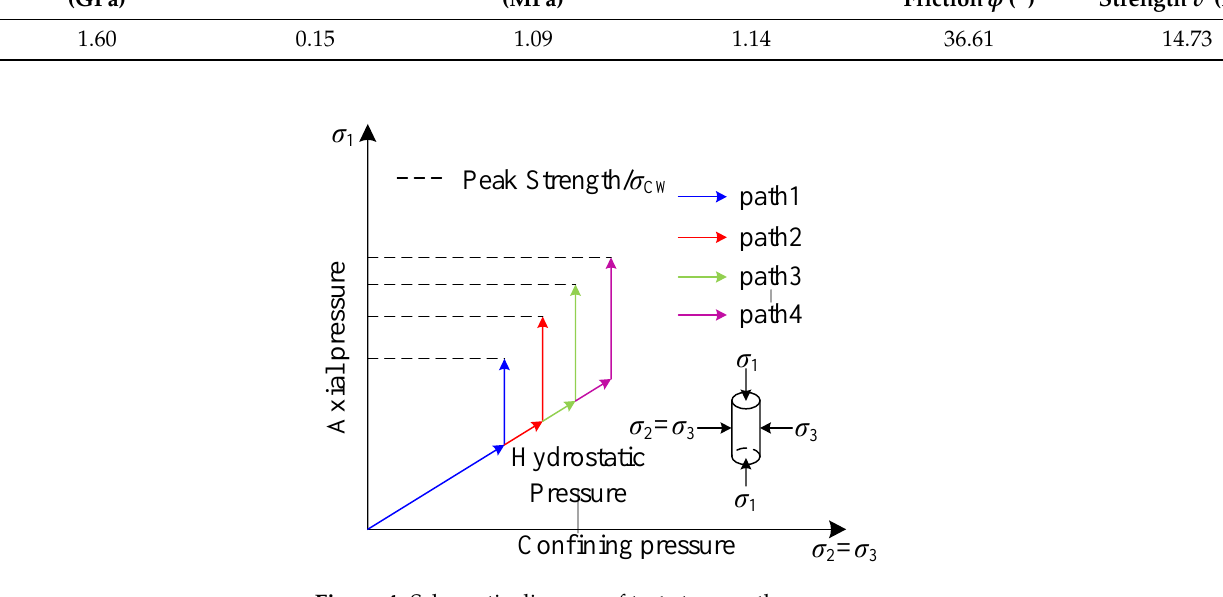
Figure 4. Schematic diagram of test stress path. Table 2. Loading test scheme.